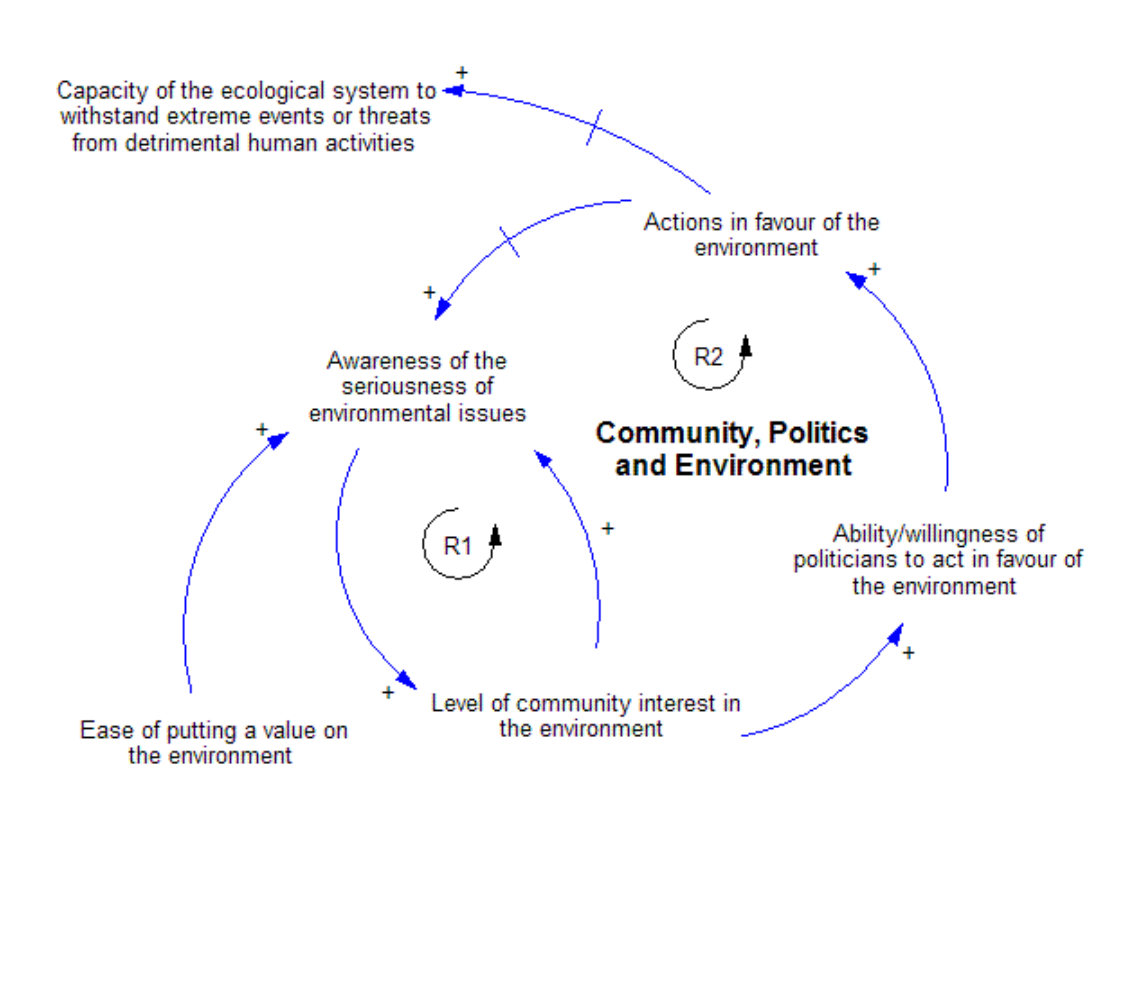
Fig. 6. Community, politics and rnvironment. The reinforcing causal loop (R1) illustrates the social effects that may result when the community takes an interest in the environment. The reinforcing causal loop (R2) illustrates the effects that this interest may produce in the political domain. As actions in favour of the environment increase, so does the capacity of the Macquarie River to withstand extreme events or threat from detrimental human